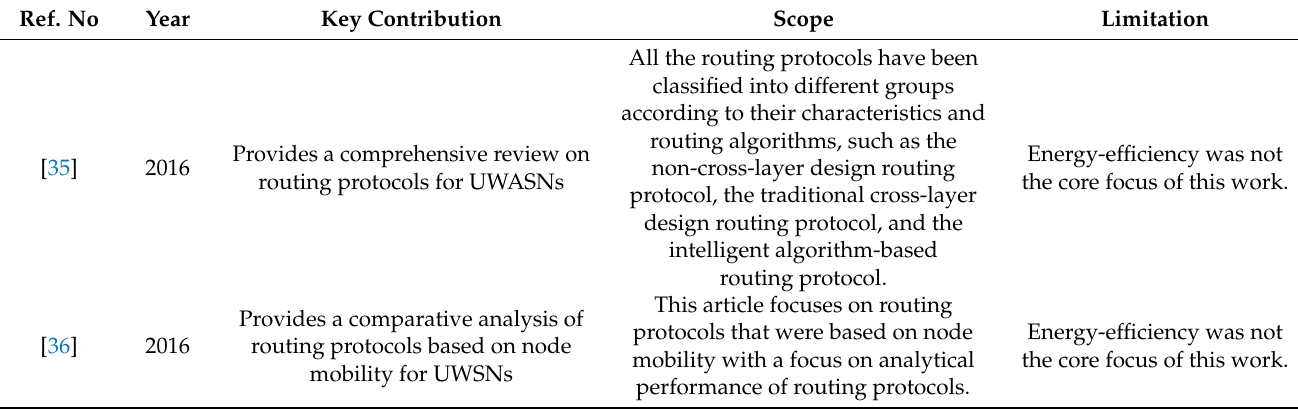
Table 1. Relevant surveys and their contributions, scopes, and